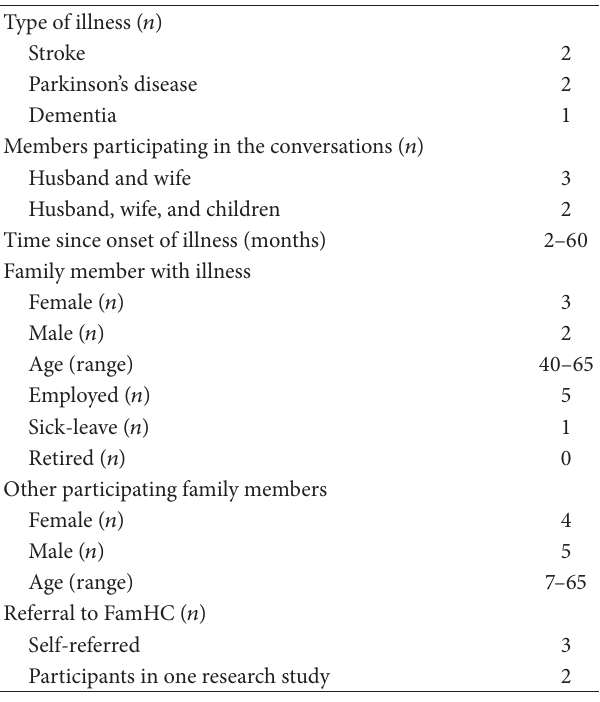
Table 1: Characteristics of the families ( 𝑛 = 5